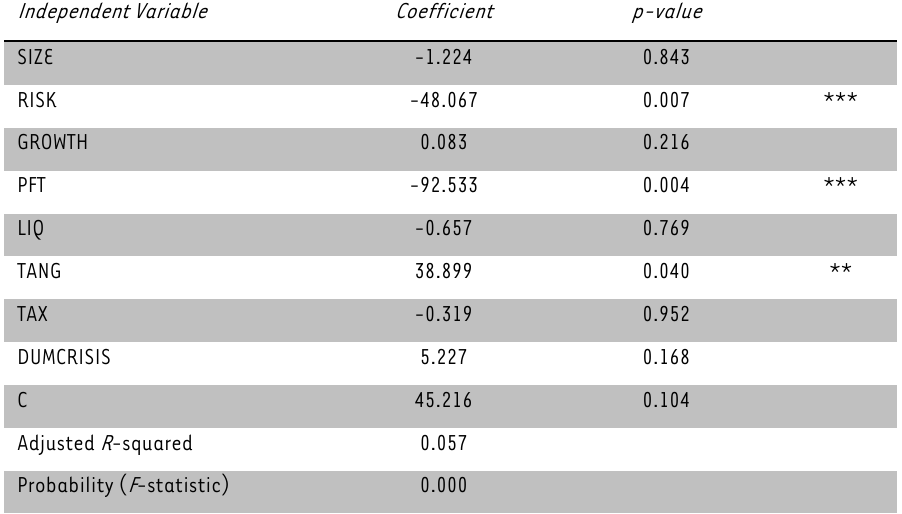
TABLE 4: Random effects model results of the relationship between independent variables and capital structure